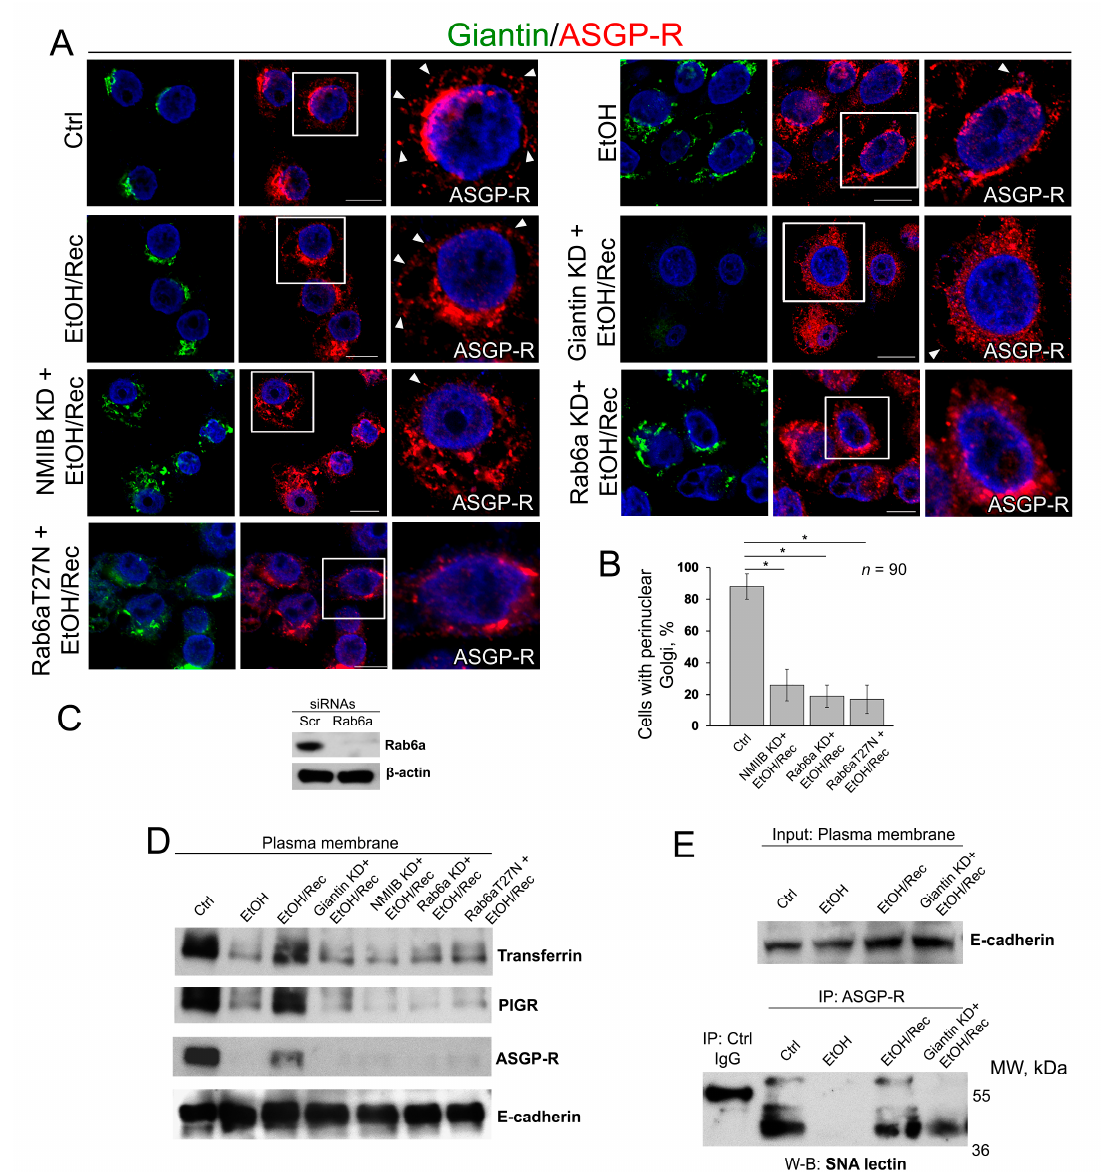
Figure 5. Giantin, Rab6a, and NMIIB are required for in vitro post-EtOH recovery of Golgi. ( A ) Confocal immunofluorescence images of giantin and ASGP-R in VA-13 cells: control, EtOH-treated cells, EtOH-treated cells and transfected with scramble, giantin, NMIIB, Rab6a siRNAs, and dominant negative (GDP-bound) Rab6a (T27N) followed by recovery. White boxes are enlarged pictures of ASGP-R presented at the right side. Arrowheads indicate ASGP-R punctae distributed at the periphery of cells. All confocal images are acquired with the same imaging parameters; bars, 10 µ m; ( B ) Quantification of cells with perinuclear Golgi for indicated cells (assessment of EtOH, EtOH/Rec and giantin KD + EtOH/Rec cells was presented in Figure 3C); n = 90 cells from three independent experiments, results expressed as a mean ± SD; * p < 0.001; ( C ) Rab6a W-B of lysates of VA-13 cells treated with corresponding siRNAs; β -actin was a loading control; ( D ) Transferrin, PIGR, and ASGP-R W-B of plasma membrane fractions isolated from VA-13 cells presented in ( A ); samples were normalized to E-cadherin; ( E ) SNA lectin W-B of ASGP-R-IP from the plasma membrane fractions isolated from VA-13 cells: control, EtOH-treated, and recovered from EtOH in absence or presence of giantin siRNAs. The input was normalized to the